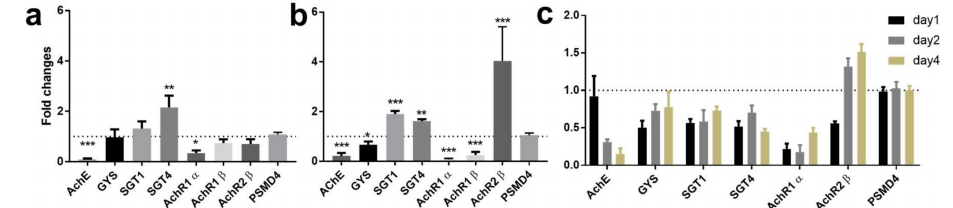
Figure 1. Modulation of transcript levels of nicotinic acetylcholine receptors and genes involved in glucose uptake in ( a ) fragmented and ( b ) intact adult S. japonicum and ( c ) eggs after treatment with SjAChE dsRNAs. mRNA levels of these genes, relative to the house-keeping gene PSMD4 , were analyzed by qRT-PCR. Data are representative of the mean ± SEM of two separate experiments. p values were calculated using one-way ANOVA to compare the gene fold changes between each RNAi group and the luciferase RNAi control group. * = p value ≤ 0.05, ** = p value ≤ 0.001, *** = p value ≤ 0.0001; p value comparing the fold changes between the targeted gene and PSMD4.